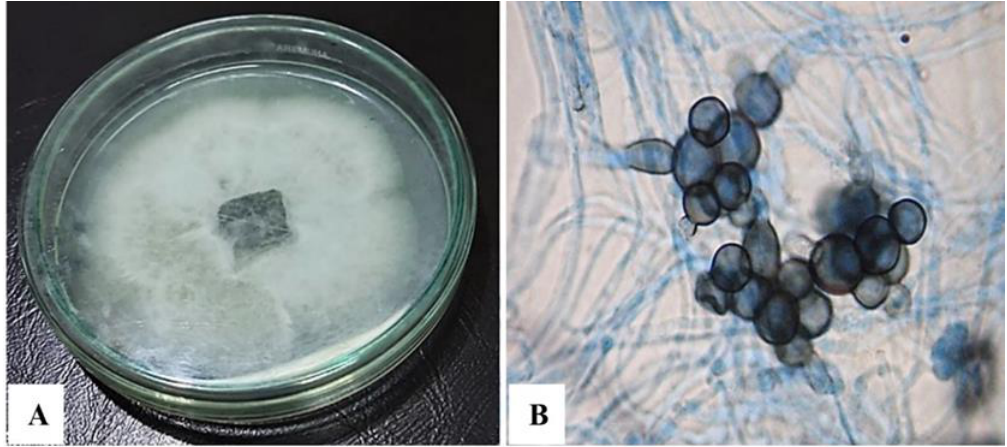
Figure 2. The morphological ( A ) and microscopic ( B ) characterization of Subramaniula asteroids .